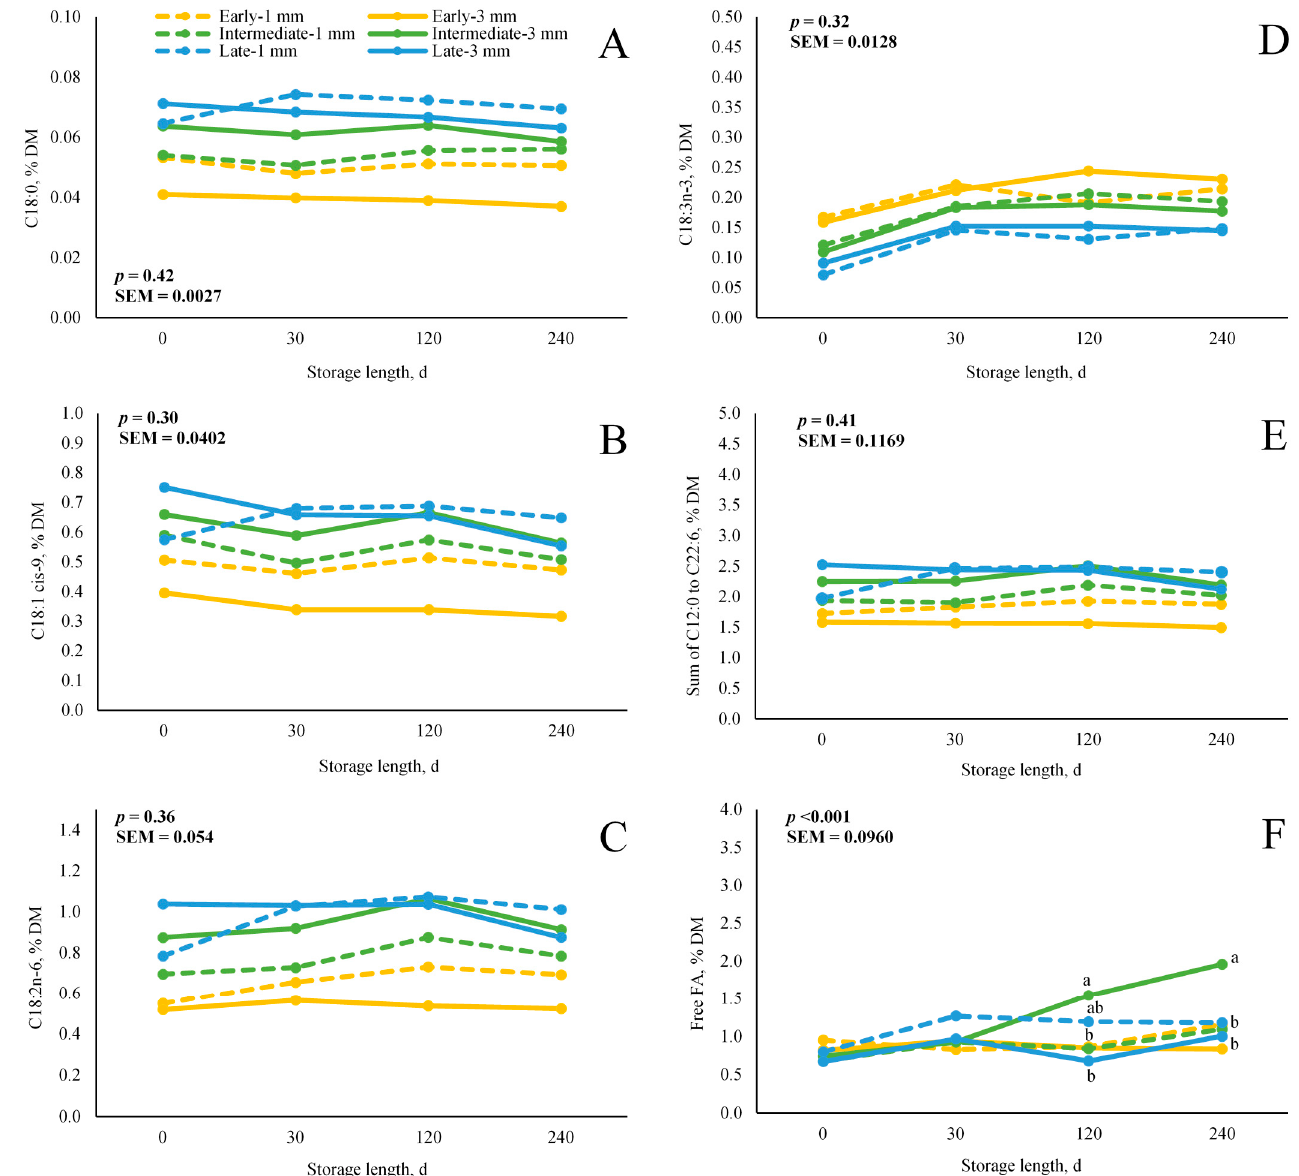
Figure 3. The effect of maturity, roll gap width, and storage length on C18:0 ( A ), C18:1 cis -9 ( B ), C18:2n-6 ( C ), C18:3n-3 ( D ), sum of C12:0 to C22:6 ( E ), and free FA concentrations ( F ) in whole-plant maize silage ( n = 96). Means within the same day with different letters (a,b) differed ( p ≤ 0.05). Whole-plant maize was harvested at 3 maturities (1/4 (Early), 1/2 (Intermediate), and 3/4 (Late) kernel milk line) and processed through rolls with a gap width of either 1 or 3 mm using a self-propelled forage harvester. Silage was stored for 0, 30, 120, or 240 d.